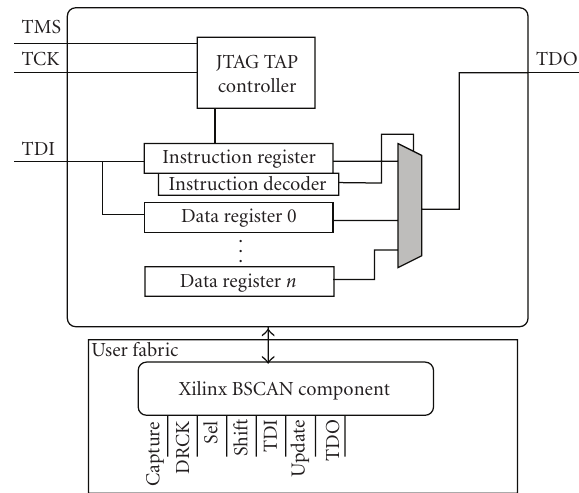
Figure 8: Xilinx internal boundary scan state machine for Virtex 4